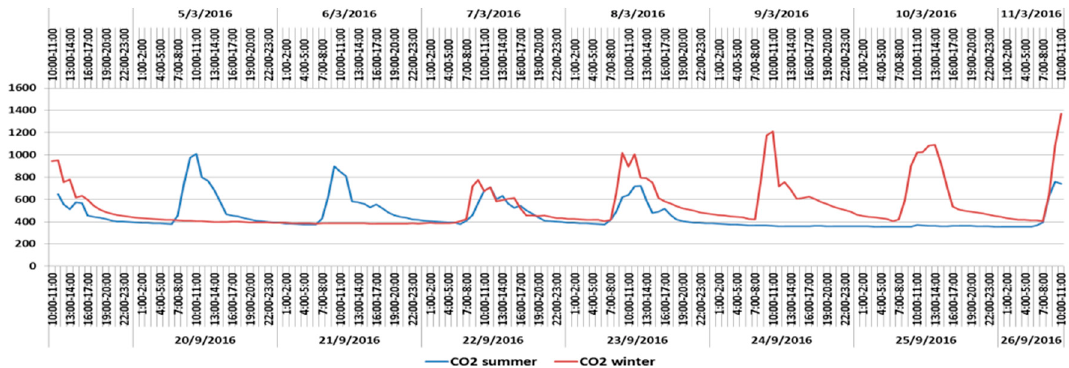
Figure 9. CO 2 levels of Building B, during winter and summer monitoring.